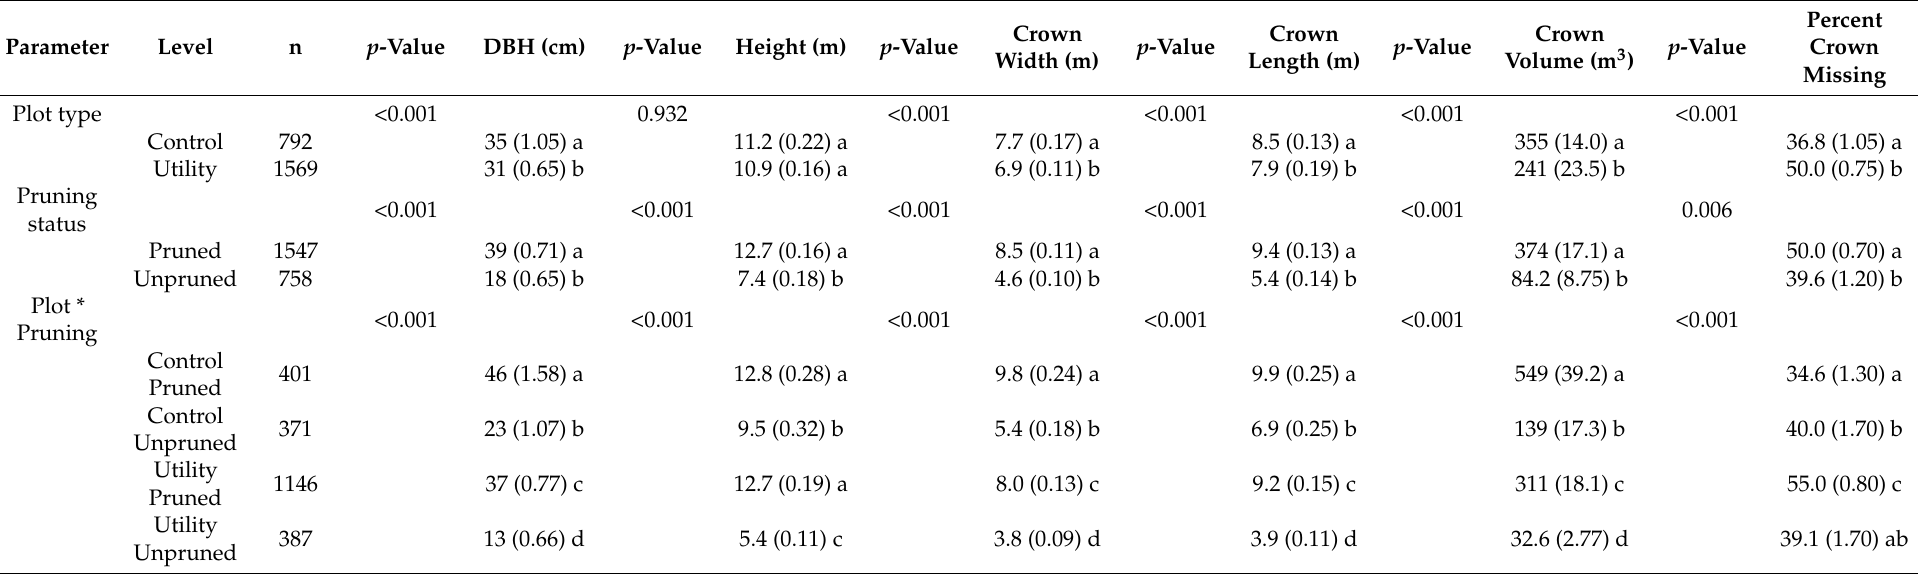
Table 1. Means (followed by standard error in parentheses) of tree size and p -values for comparisons between plot types, pruning status, and their interaction; within each effect or their interaction, means followed by the same letter are not significantly different ( p > 0.05) by Tukey’s Honestly Significant Difference test. Crown volume was corrected for percent crown